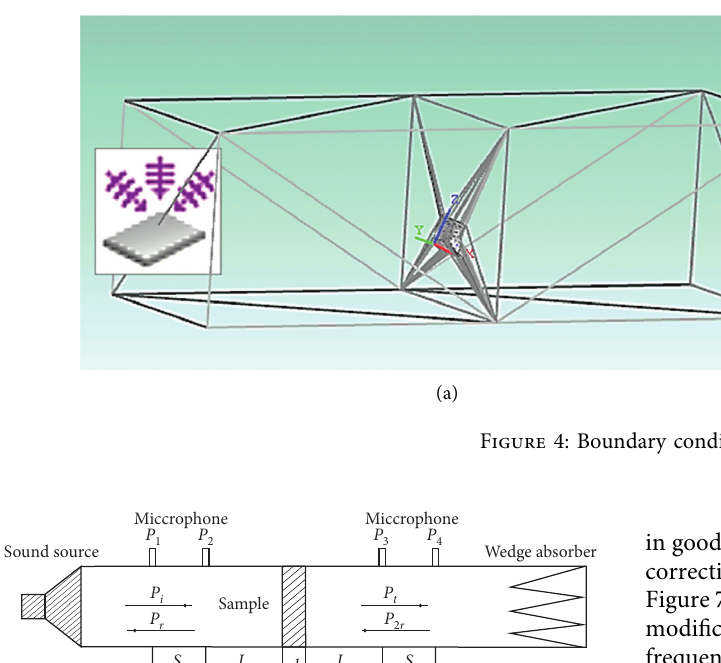
Figure 5: Transmission loss test principle of the four-microphone